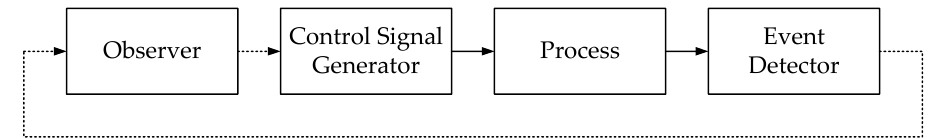
Figure 1. Basic scheme of an event-based control system. Solid arrows represents continuous signal and dashed arrows represents event-based